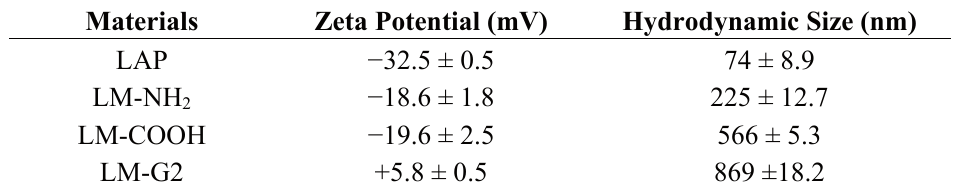
Table 1. Zeta-potential and hydrodynamic size of the LAP, LM-NH 2 , LM-COOH, and LM-G2.